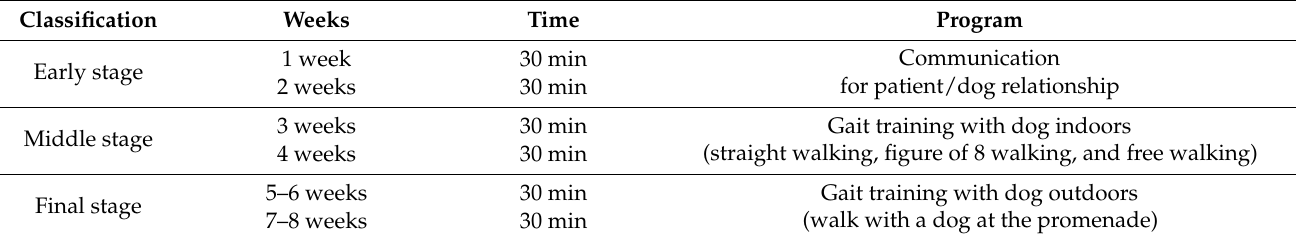
Table 1. Animal-assisted therapy for stroke